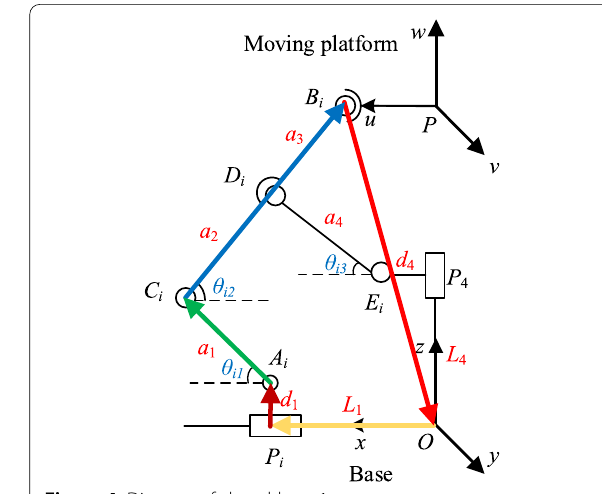
Figure 3 The geometric structure of the mechanism Figure 4 Diagram of closed-loop